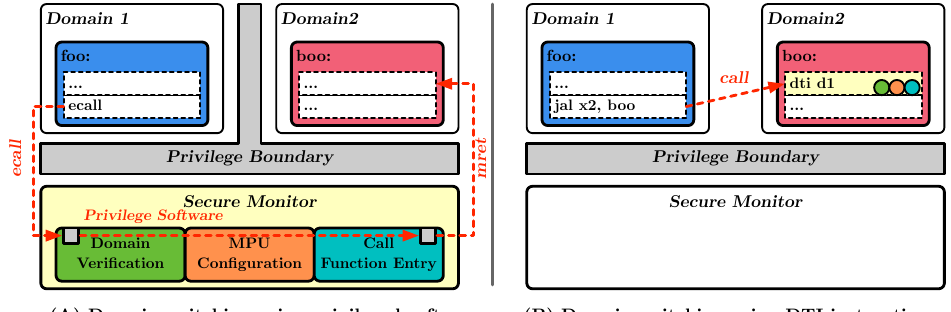
Figure 5. Domain-switching overhead in DEMIX .